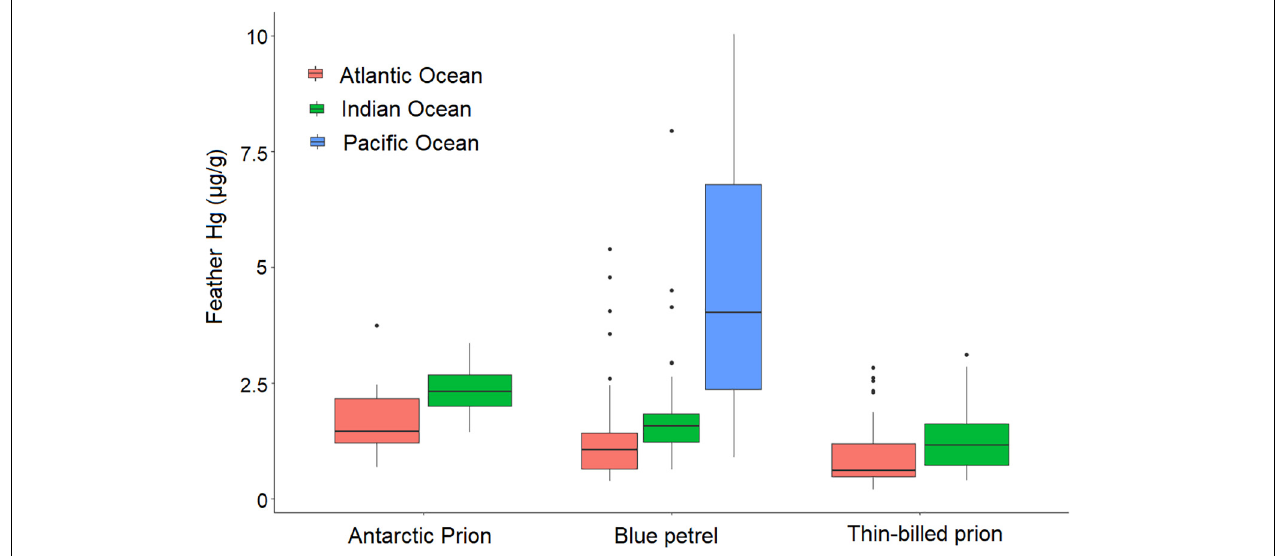
FIGURE 5 | Mercury values in feathers of Antarctic Prions, Blue Petrels, and Thin-billed Prions from different ocean basins. Boxplots showing medians, interquartile ranges, and outliers.